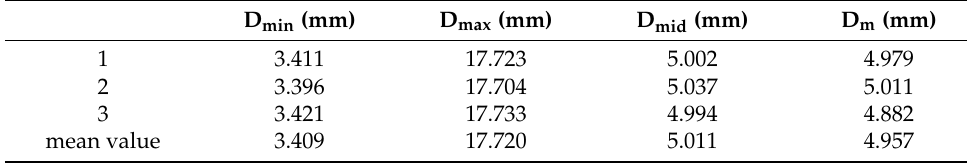
Table 4. The measured thickness of the bearing